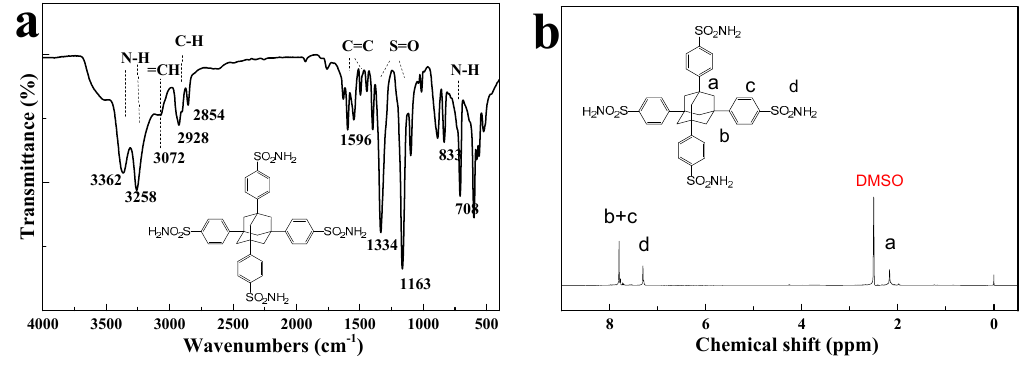
Figure 1. ( a ) FTIR spectrum and ( b ) 1 H NMR spectrum of FRSN.